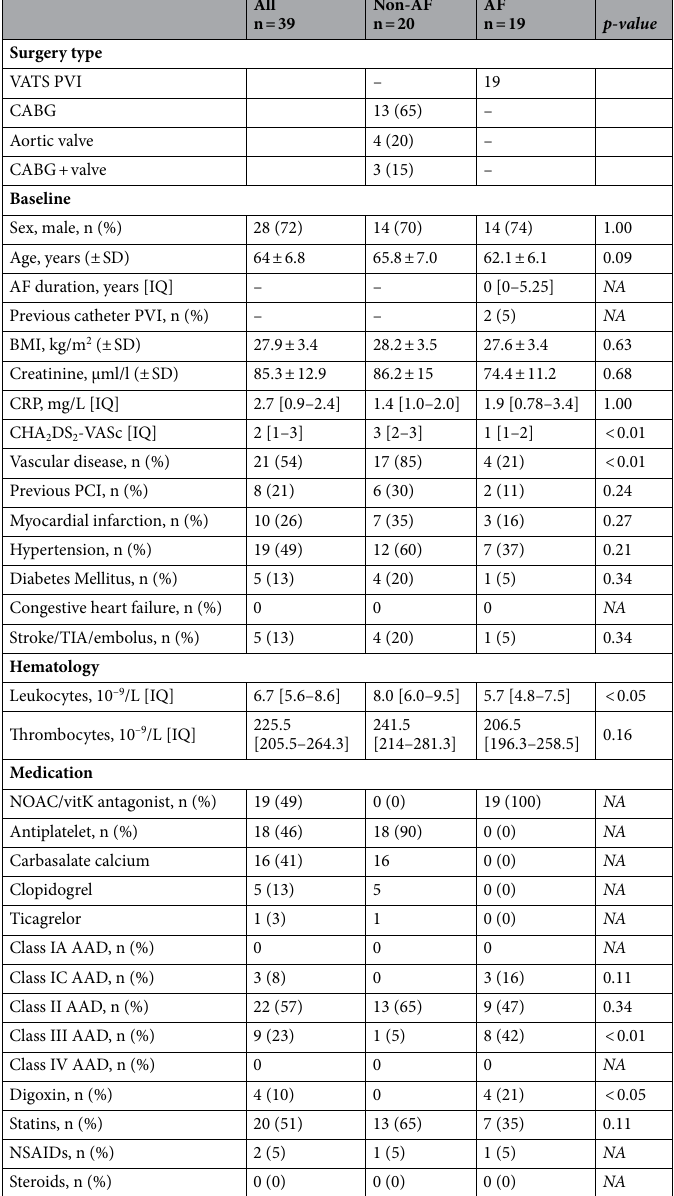
Table 2. Clinical characteristics of the patients enrolled for the validation study. The cohort for the validation study contains 20 non-AF patients and 19 persistent AF patients. VATS PVI video-assisted